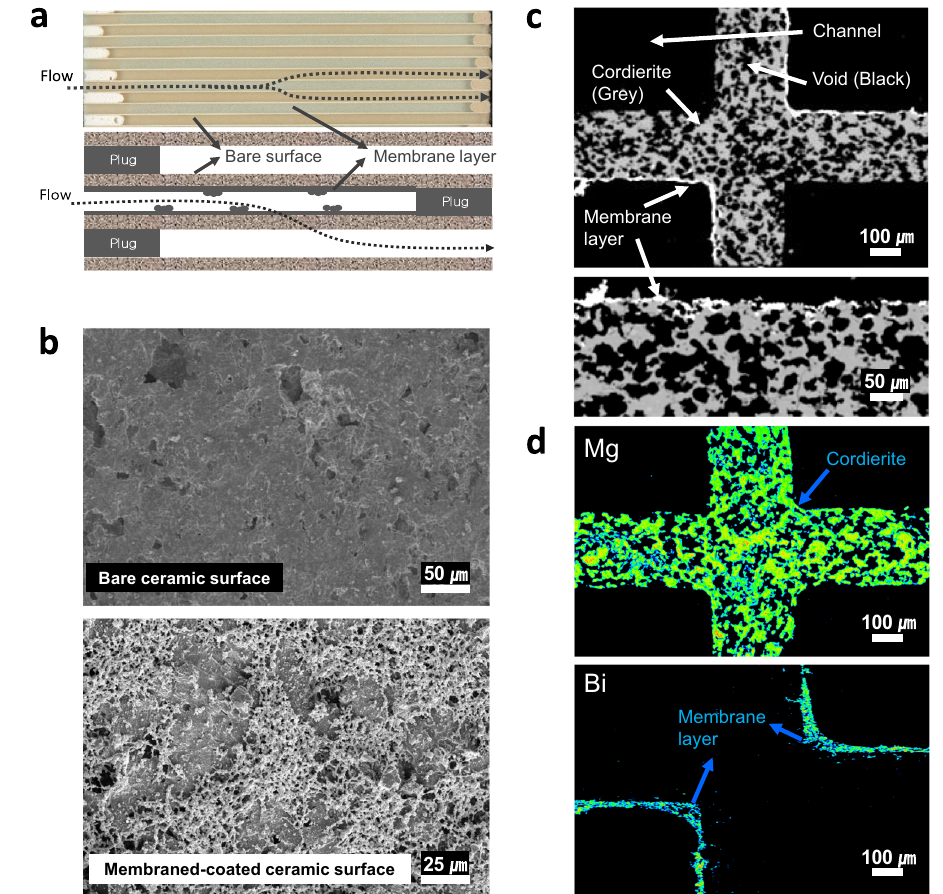
Fig. 2 | CCF coated by inorganic membranes. a Inner channels of CF and illus- tration of PM removal by wall- fl ow fi ltration in the CF. b SEM images before and after inorganic coating to fabricate the membrane on the CF cell surfaces. c SEM